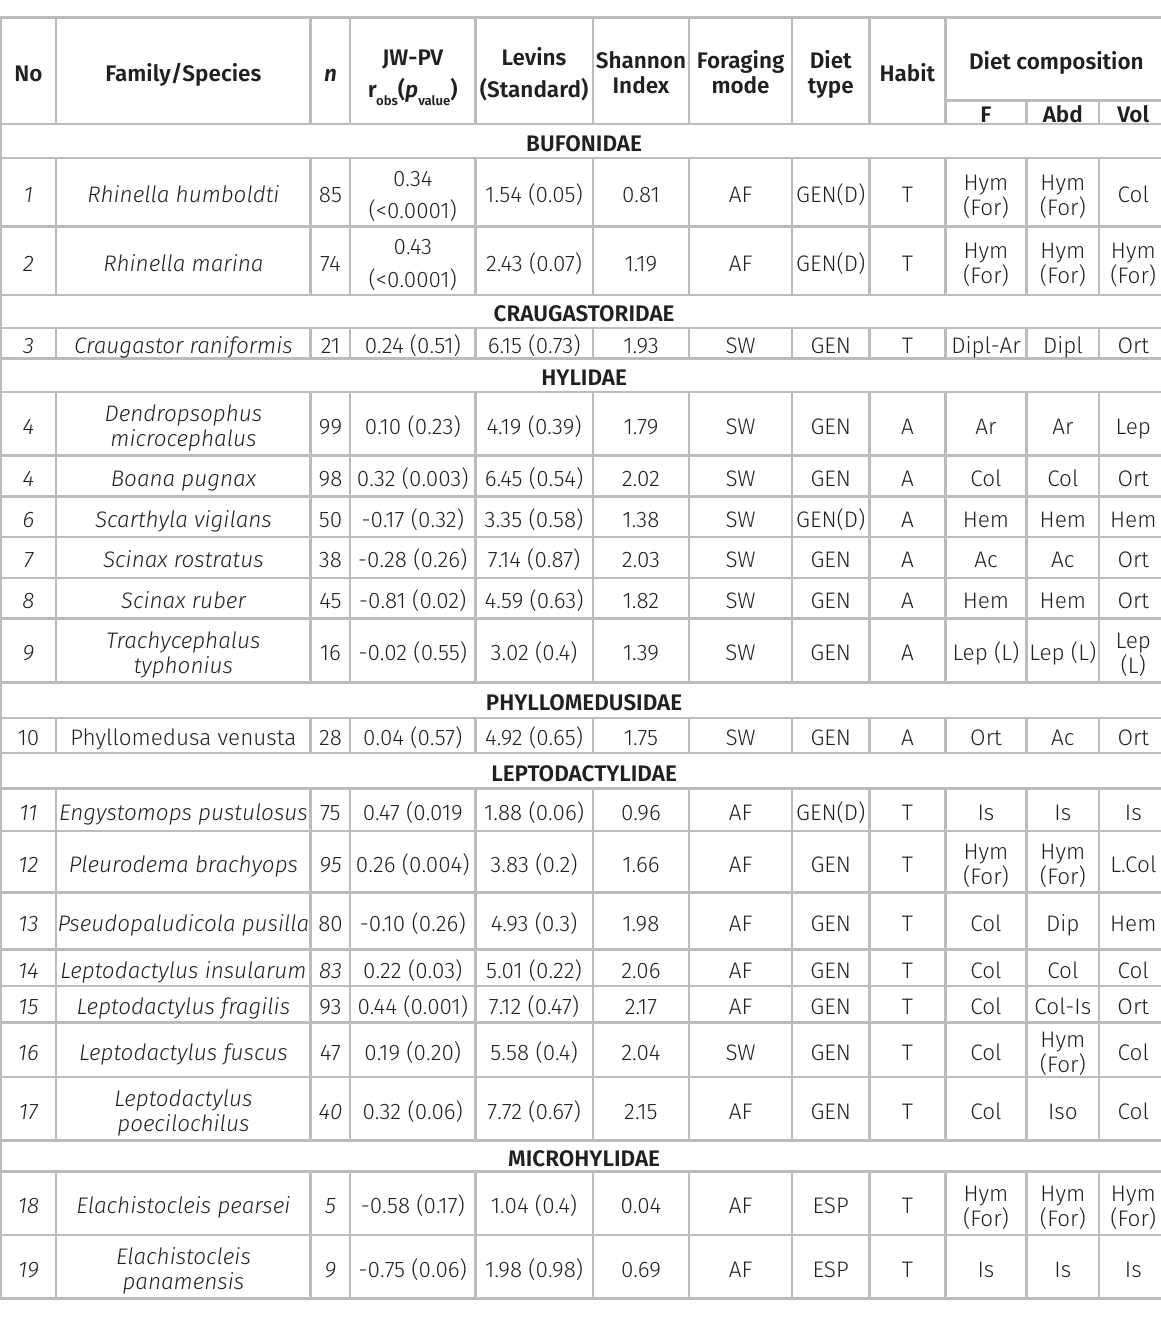
Table I. Dietary characteristics of the anuran species studied in tropical dry forests of Caribbean Colombia. n = Number of stomach. JW-PV= Relationship between predator and prey size using jaw width and prey volume. Amplitude = Amplitude of Levins index, the standardized amplitude value is shown in brackets; Diversity = Diversity of trophic niche (Shannon index); Foraging Mode = SW: Sit-and-wait, AF: Active forager; Diet Type = GEN: Generalist, ESP: Specialist, GEN (D): Generalist with predominancia; Habit = T: Terrestrial, A: Arboreal; Diet composition = F: prey group or order with more frequent occurrence (highest occurrence value), Abd: prey group or order with greater number of individuals, Vol: prey group or order with greater volume ingested; Hymenoptera, Is = Isoptera, Iso = Isopoda, L = Larvae, Lep = Lepidoptera, Ort = Orthoptera. Data taken from this research, Blanco- Torres et al. (2019) and Blanco-Torres et al.